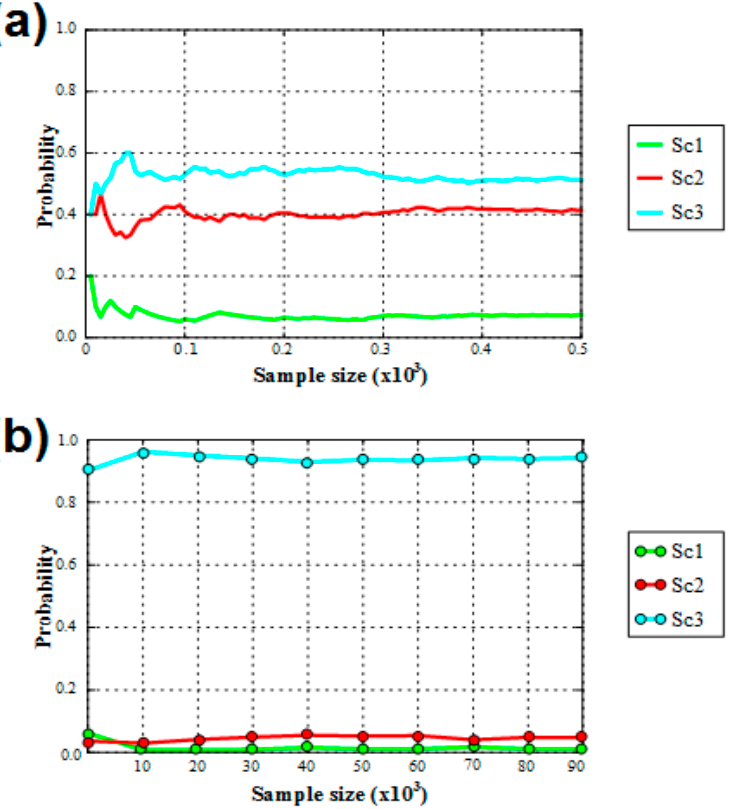
Figure 5. Posterior probability of scenarios according to the ABC modeling for Anodonta anatina lineages (evaluating the confidence in scenario choice determined using the direct ( a ) and linear regression ( b ) approaches.) Table 4. Posterior probabilities of the three biogeographic scenarios.